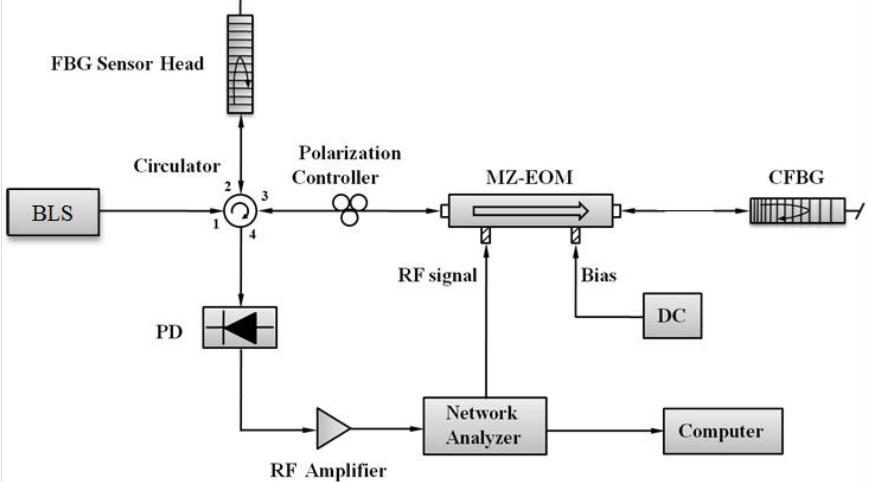
Figure 1. Setup for the proposed RF interrogation structure of an FBG sensor using bidirectional modulation of an MZ-EOM. BLS: broadband light source. MZ-EOM: Mach-Zehnder electro-optical modulator. CFBG: chirped fiber Bragg grating. PD: